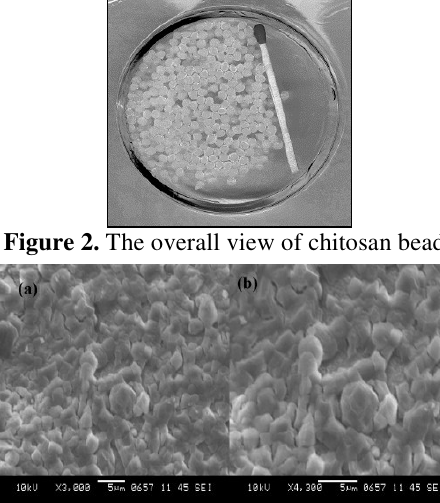
Figure 3. SEM images showing the surface morphologies of the chitosan beads; (a) at 3000 × and (b) 4300 × magnifications